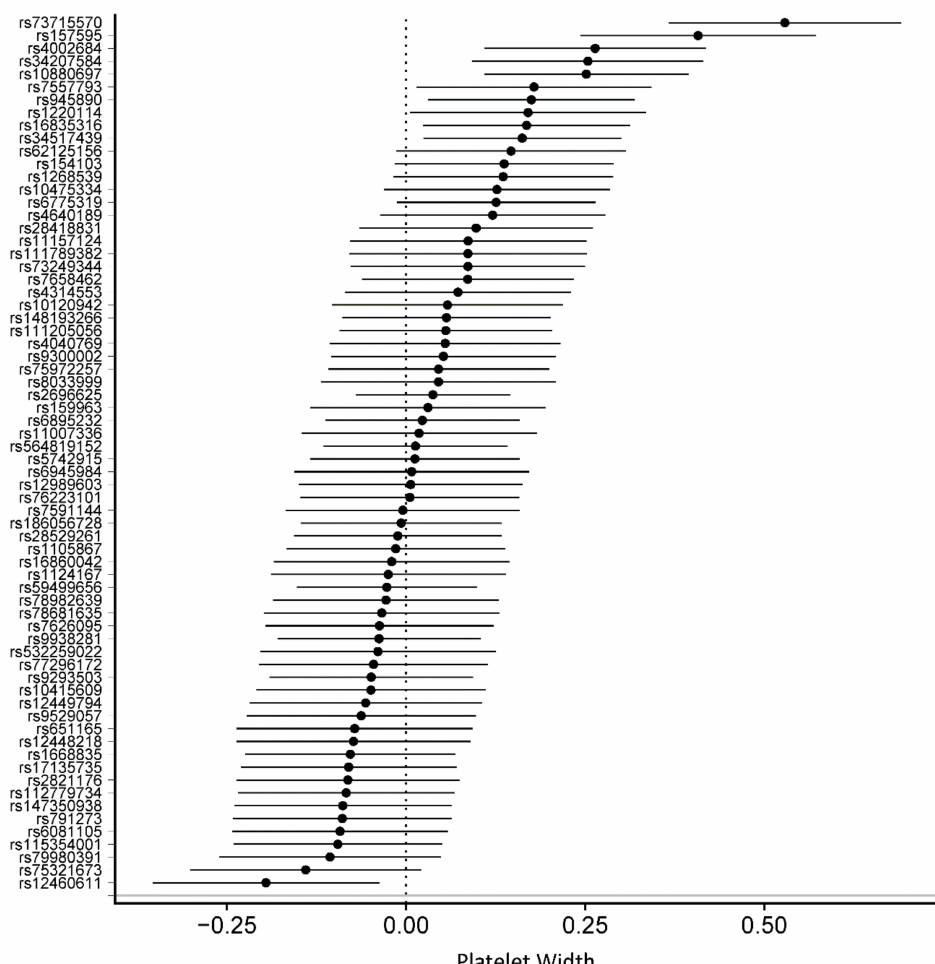
Figure 3. Forest plot of physical activity single nucleotide polymorphisms on platelet